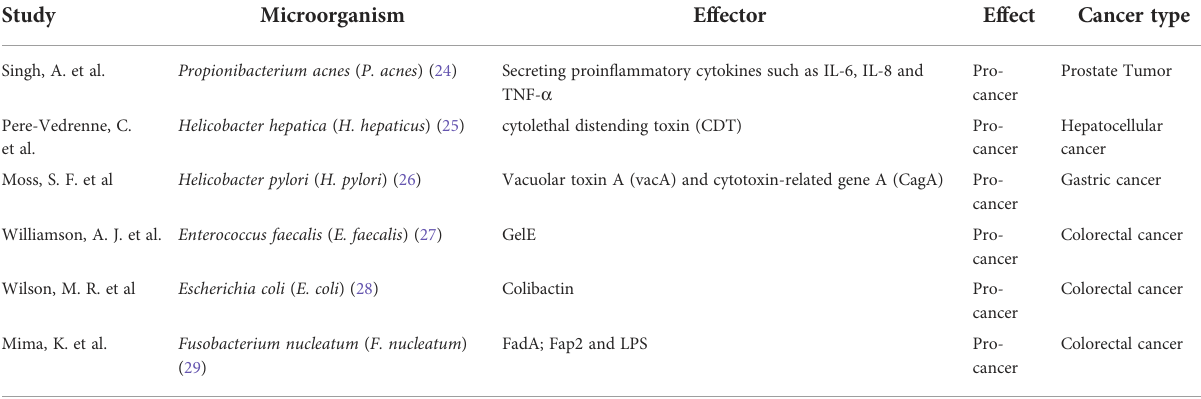
TABLE 1 The effect of substances of gut microbiota in